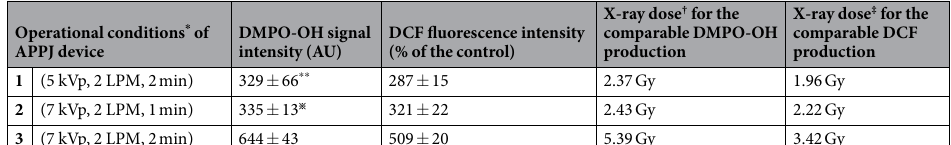
X-ray dose ‡ for the comparable DCF